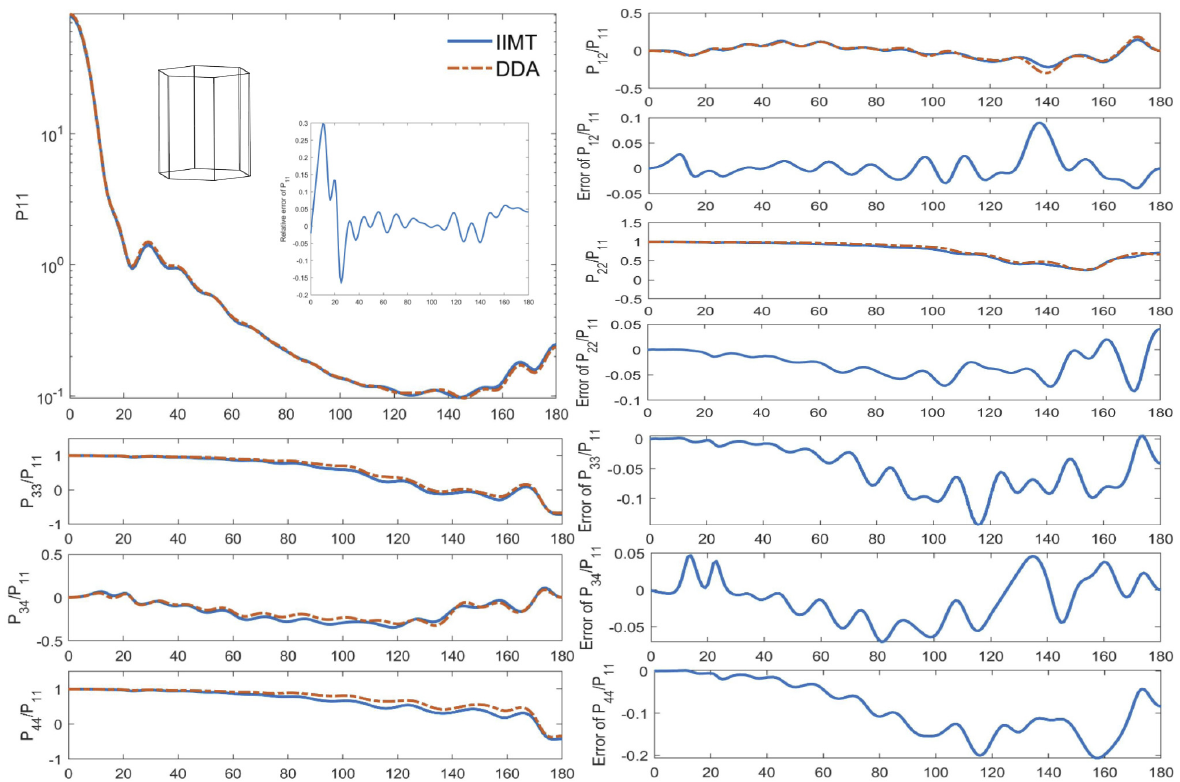
Figure 6. The phase matrices and their errors calculated by the IIM T − matrix and DDA methods for small hexagonal prism particles with random orientations. The abscissa is the scattering angle. The solid line is the IIM T − matrix model and the dashed is DDA model. The errors of P 12 /P 11 , P 22 /P 11 , P 33 /P 11 , P 34 /P 11 and P 44 /P 11 are absolute errors.